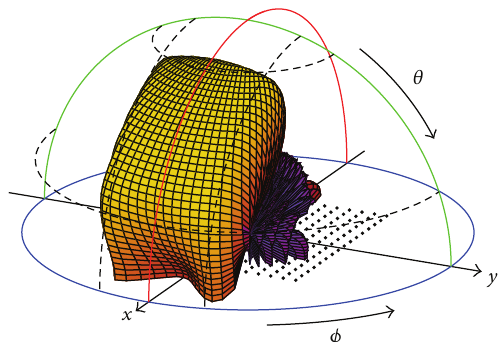
Figure 4: Steering the SRA-256 𝑆 𝑓 pattern over the principal 𝑥 -axis (0 ∘ , 35 ∘ ) broadens its shaped region in that direction.